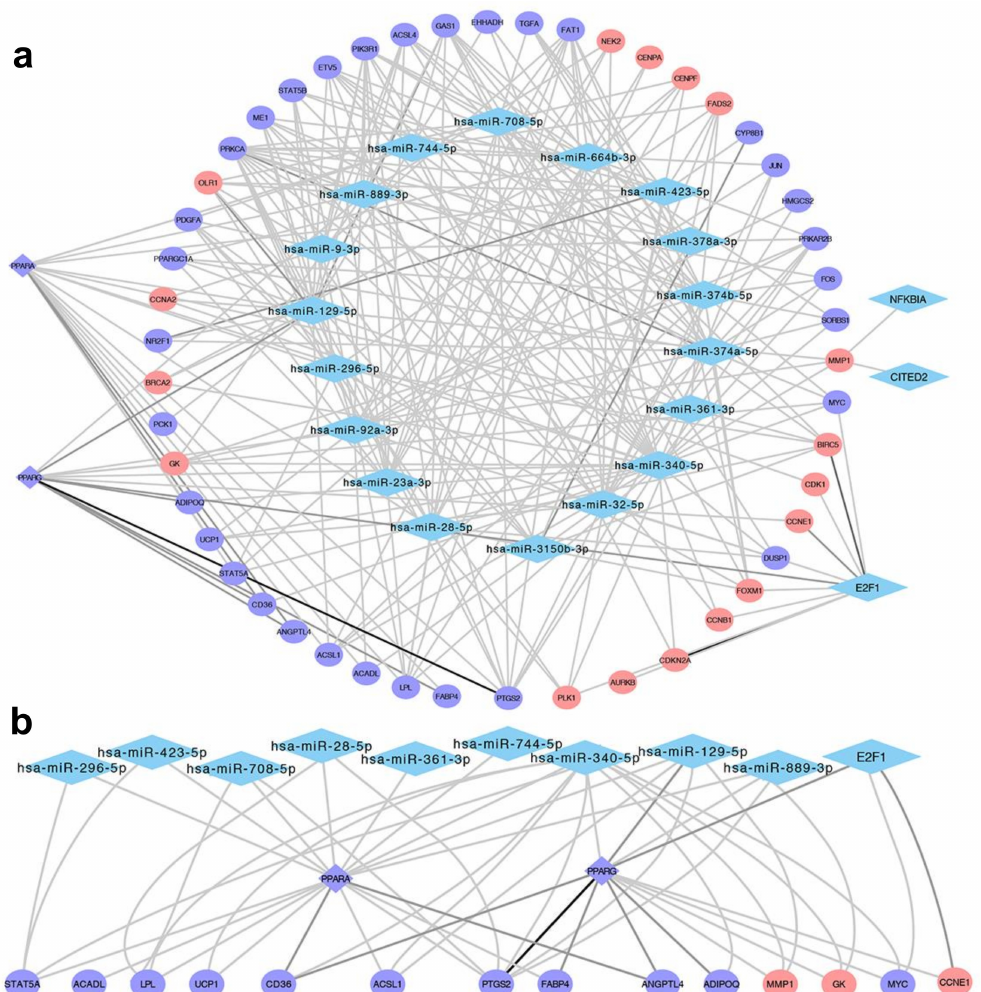
Figure 5. TF-target and miRNA-target regulatory networks. ( a ) The network comprises 23 selected regulators (21 blue diamonds and 2 red diamonds) with nonzero predicted interactions with PPAR/FOXM1 pathway-related genes (circles) obtained from MSigDB. The red and purple circles indicate Yin (upregulated) and Yang (downregulated) genes, respectively. The color of edges ranging from grey to black corresponds to an order of increasing number of hits. ( b ) A subnetwork contains PPARA and PPARG, their targets, and regulators that regulate them. A 2-layer hierarchical structure forms with 10 upstream regulators, including 9 miRNAs and E2F1 on the top layer, and two downstream regulators PPARA and PPARG arranged at the bottom